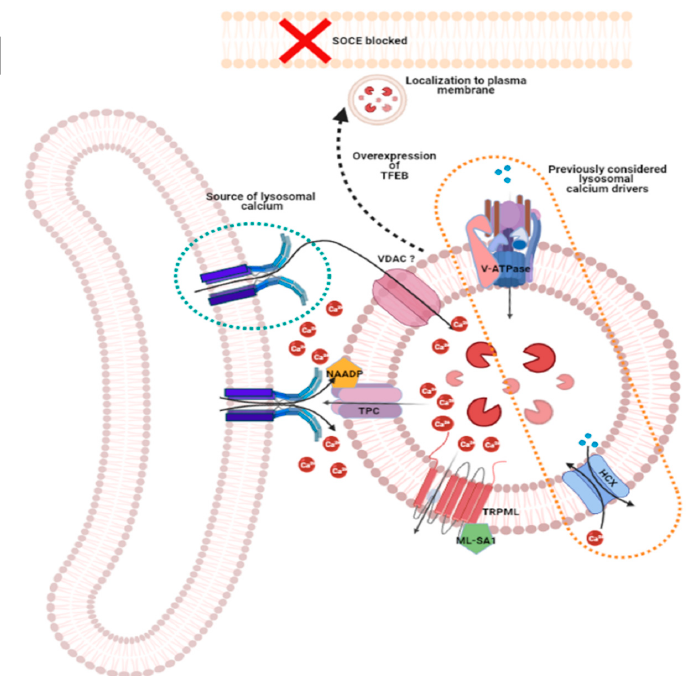
Figure 9. Mitochondrial and lysosomal impact on intracellular Ca 2+ signal. ( A ) Primary components of Ca 2+ signaling at the mitochondrial associated membranes (MAMs) include IP 3 R3 on the endoplasmic reticulum, VDAC1 on the outer mitochondrial membrane, and MCU complex on the inner mitochondrial membrane [151,154,156,161]. Transport of Ca 2+ ions from ER to mitochondria plays a crucial role in cellular metabolism (autophagy), cell survival (during unfolded protein response and impinging cell death signals), lipid production, and distribution [162–166]. For these cellular processes to proceed normally, the integrity of MAMs is essential. Various tethering proteins regulate MAM structural integrity. Such secondary MAM components include GRP75, PML, GRP78 (or BiP), mitofusins (MFN1 and 2), and phosphofurin acidic cluster sorting protein (PACS2) [158–160,164,167–169]. Localized to the ER side of MAMs, growth factor-activated mTORC2 utilizes phosphorylated PACS2 (via Akt) to help avoid structural disruption of this sub-compartment [170]. It also phosphorylates IP3R3 to promote Ca 2+ release at MAM sites. Other key MAM localized proteins maintain Ca 2+ homeostasis in the region. These are calreticulin and calmodulin in the ER lumen, and SERCA on the ER membrane (184).